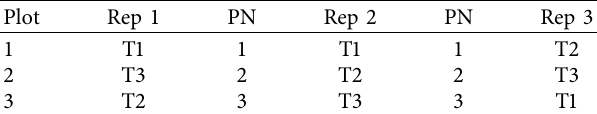
Table 2: Field layout of the experiments.